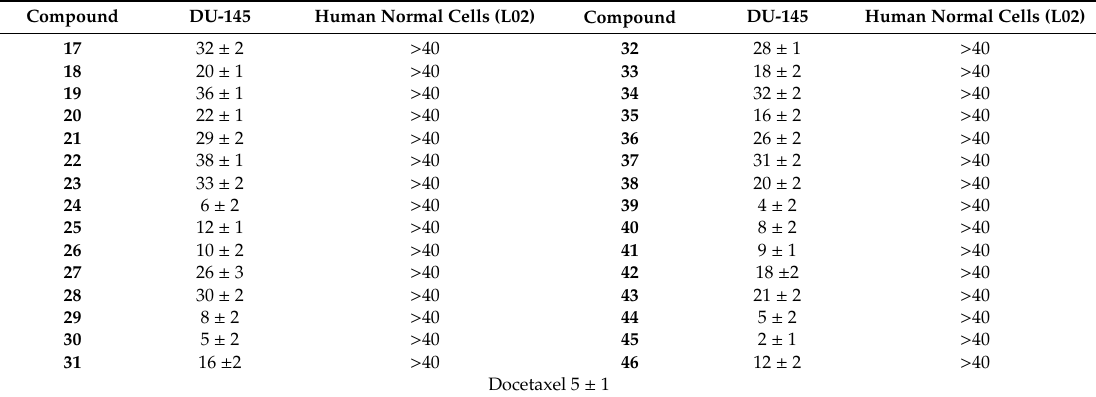
Table 4. Comparison of the MTT assay anticancer results of chalcones ( 17 – 31 ) and dihydropyrazoles